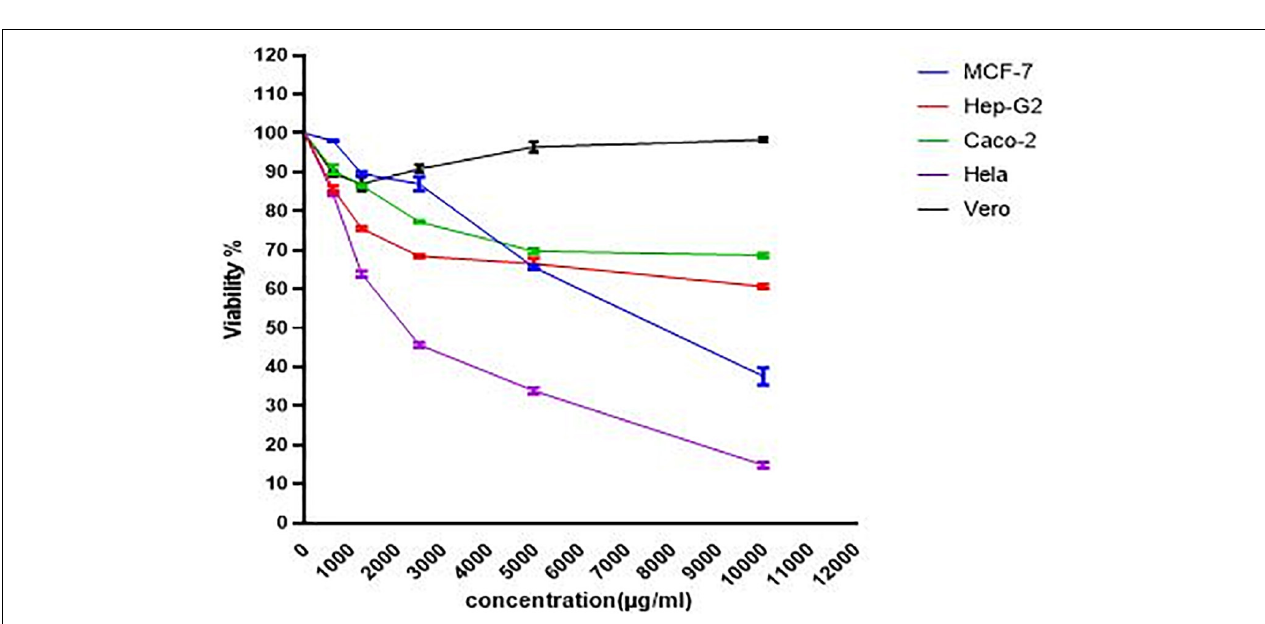
FIGURE 3 | The viability dose-response curve for normal and cancer cells cultured with PoPE (10–0.625 mg/mL) for 24 h at 37 ◦ C. GraphPad Prism was used to calculate the results.